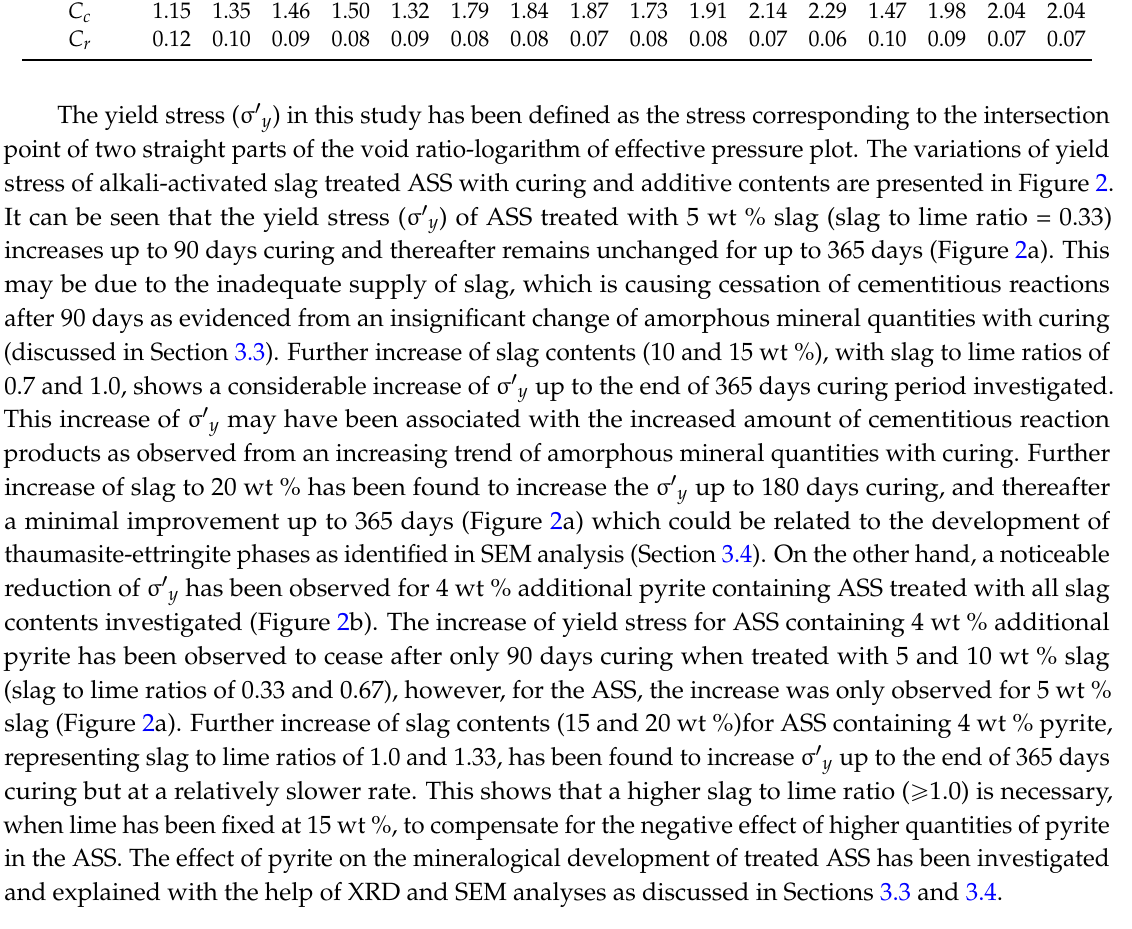
Table 3. Compression properties ( C c , C r ) of alkali-activated slag treated ASS.